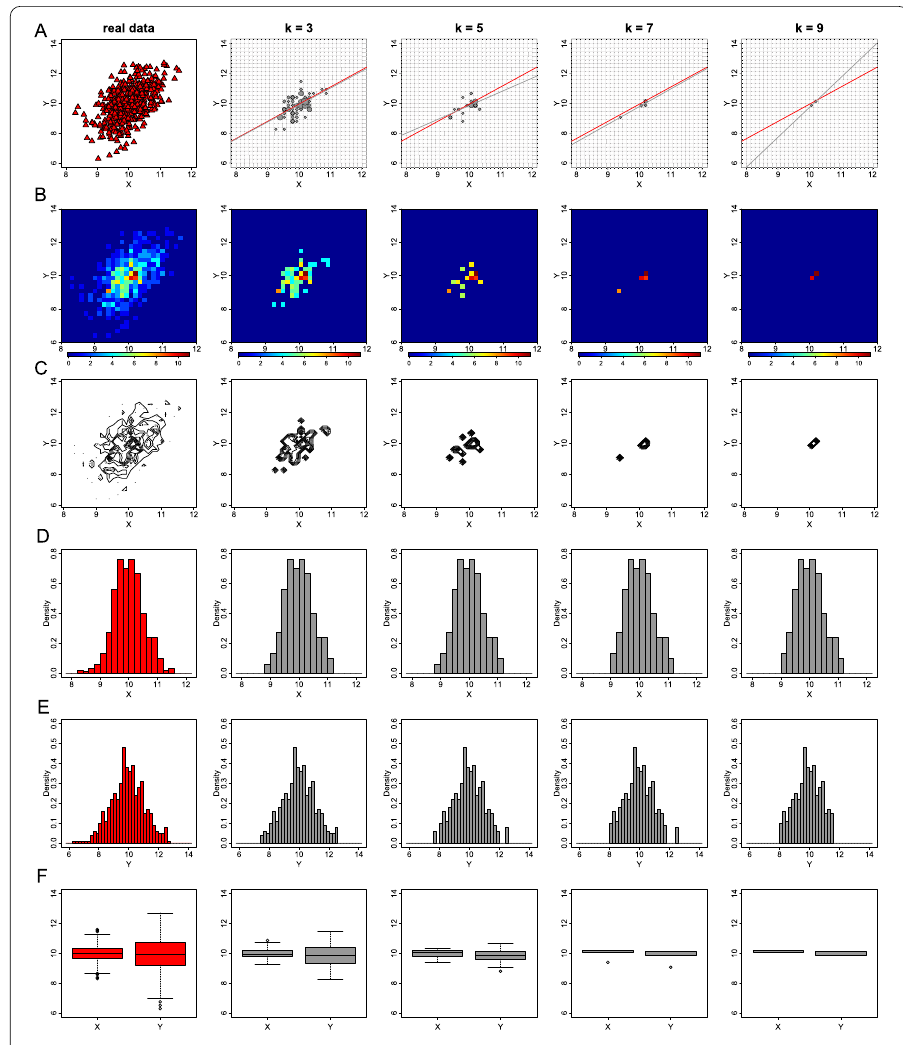
Figure 8 The effect of parameter k of the k -anonymization method on exploratory data visualizations. From left to right we demonstrate the effect of k for the values of 1 (this is equivalent to the real data), 3, 5, 7 and 9 on generating privacy-preserving scatter plots ( A ), heat map plots ( B ), contour plots ( C ), histograms of X ( D ) and Y ( E ), and box plots ( F )